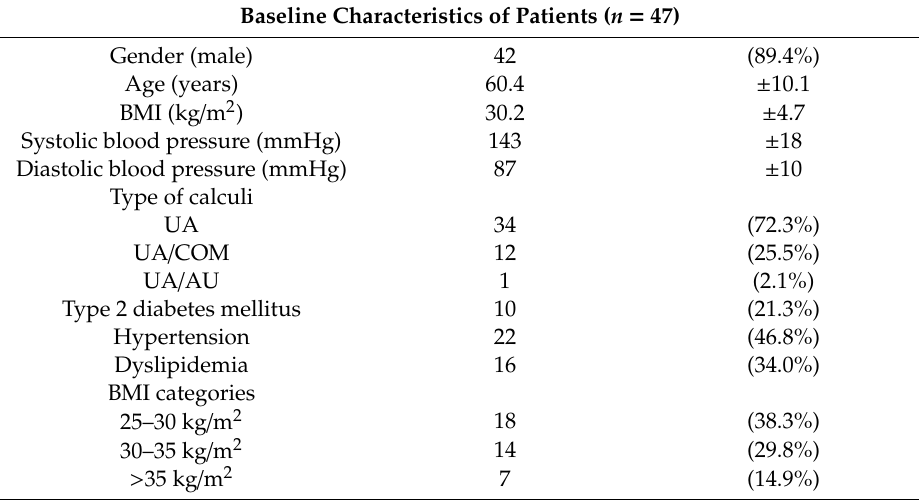
Table 1. Baseline characteristics of patients ( n = 47). Each value is given as mean ± SD or number